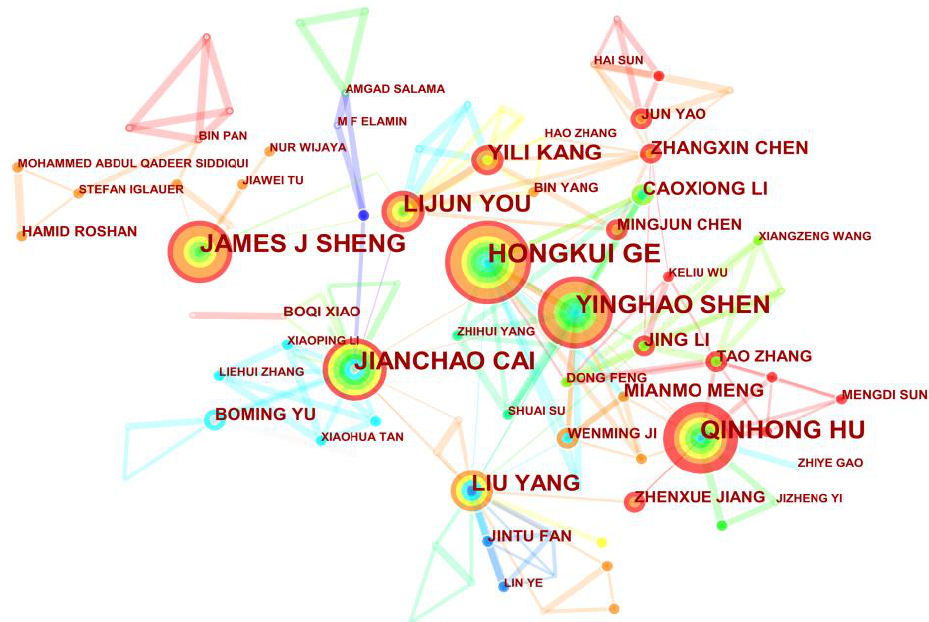
Figure 6. Author cooperation network.